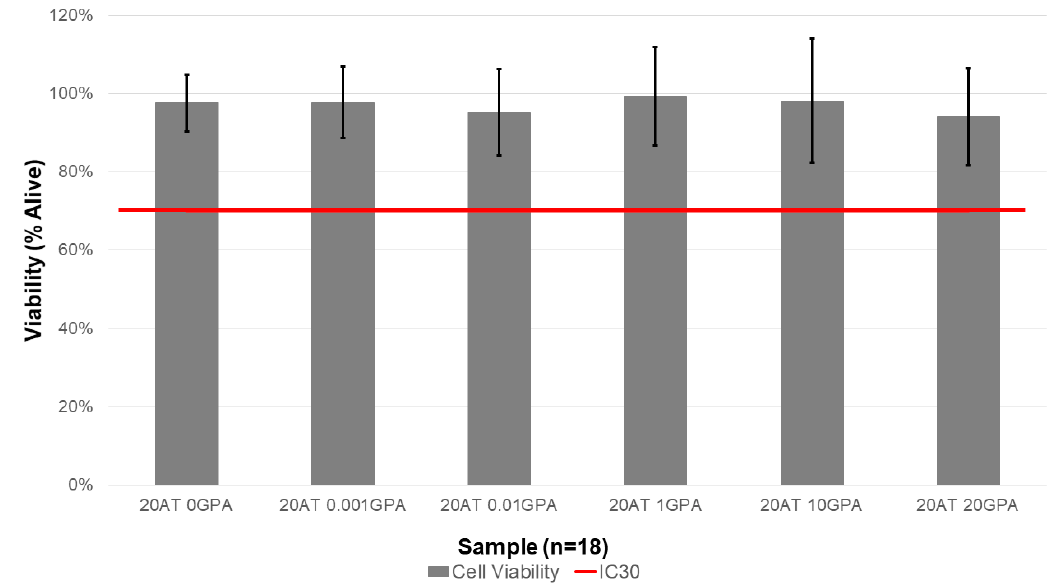
Figure 8. Cell viability was calculated from fluorescence in resazurin assay performed upon 3T3 cell